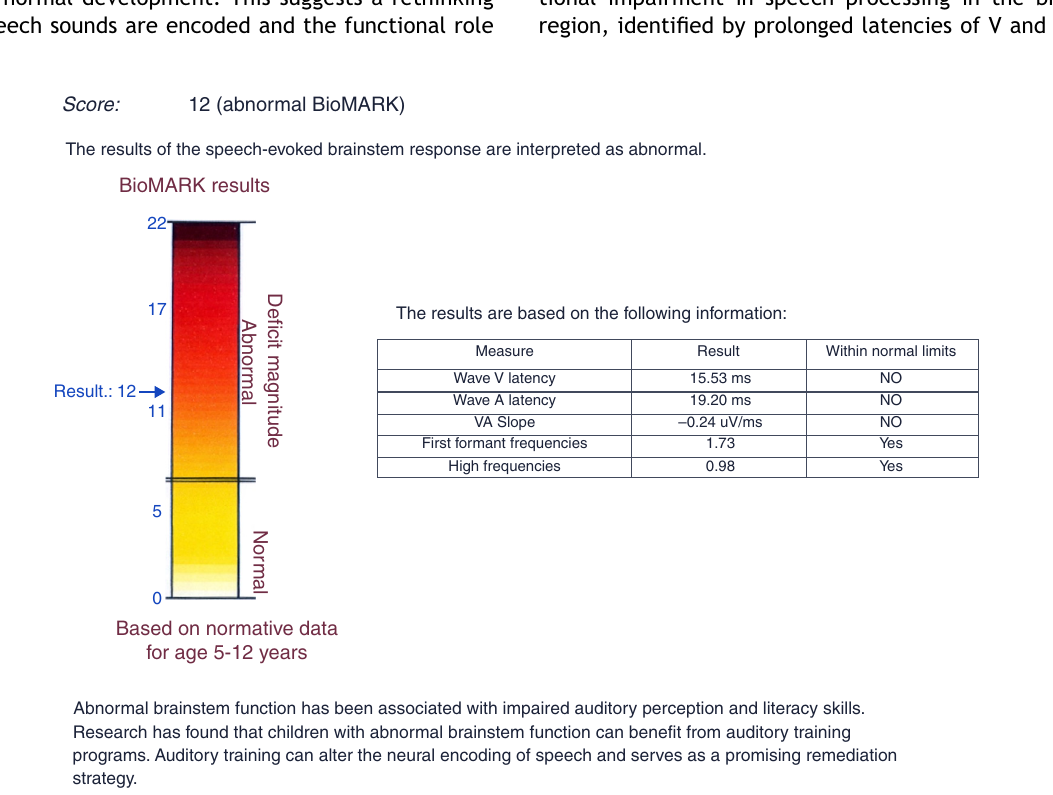
Brainstem-evoked response audiometry with speech stimulus and altered responses. Researcher’s data from a male patient (10 years